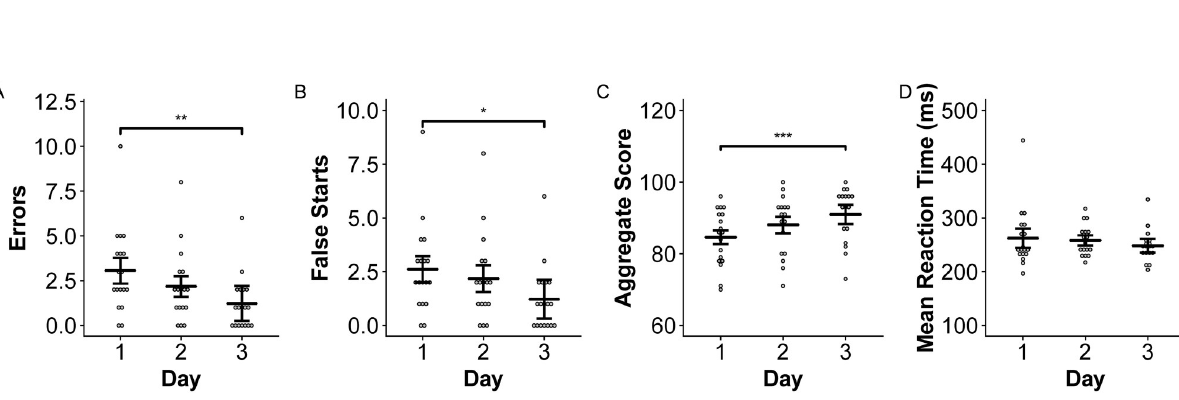
Fig 7. Errors and false starts on the PVT decrease following acclimatization. Errors and false starts decreased over three days at high altitude, resulting in higher aggregate scores on day 3. Mean reaction times did not decrease significantly with acclimatization. Means and 95% confidence intervals are provided for each day. Asterisks indicate significant differences across days at p < 0.05 ( � ), p < 0.01 ( �� ), and p < 0.001 ( ���